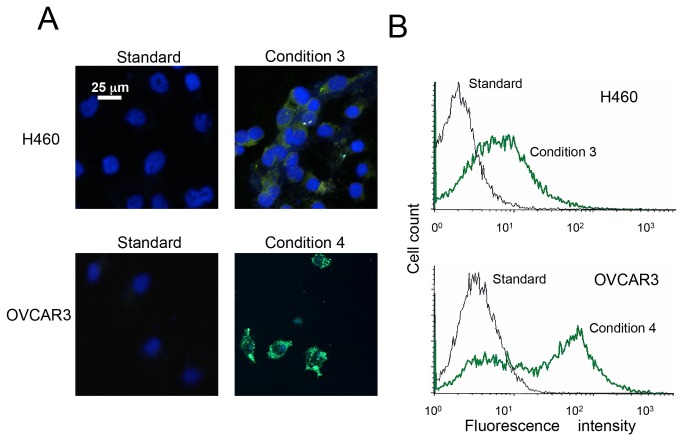
Hypoxia, EC-specific growth medium, and nutrient deprivation induce Tie2-dependent EGFP expression in tumor cells.Separate cultures of H460 and OVCAR3 tumor cells were stably co-transfected with Tie2-EGFP plasmid and pFR400 encoding a mutant form of dihydrofolate reductase [36,37] and selected in G-418 and increasing concentrations of methotrexate to allow amplification of the two tandemly integrated vectors and a corresponding increase EGFP signal intensity. Cells were exposed to conditions shown previously to induce the maximal TDEC phenotype (i.e., condition 3 for H460’s and condition 4 for OVCAR3) and compared to control cells grown under standard conditions. (A) Fluorescence micrographs of each cell line after five days of growth under each set of conditions. (B) Flow cytometric analysis of the same cells. Representative results of at least three independent experiments are depicted. Scale bar = 25 um.